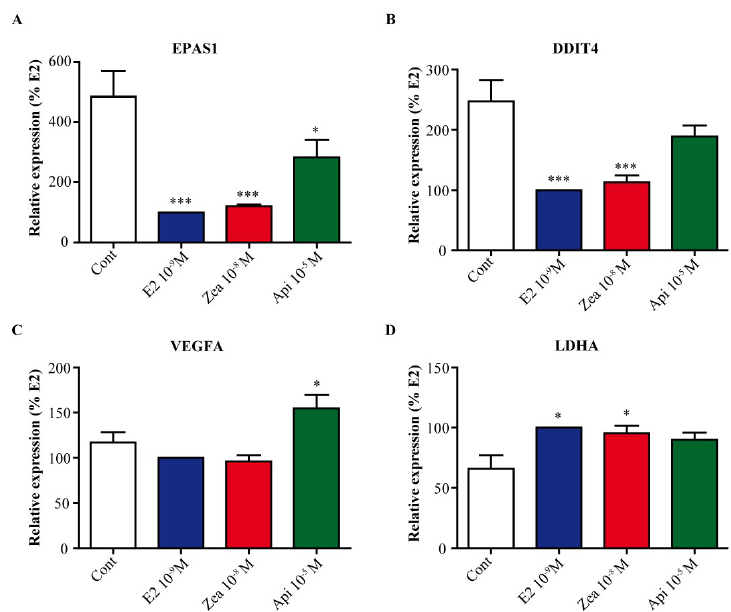
Figure 8. Validation of metabolism and growth arrest genes linked to HIF1α and EPAS1/HIF2α.MCF-7 cells were treated with solvent (white) as a negative control, 10 −9 M E2 (blue) as a positive control, 10 −8 M zearalenone (red) or 10 −5 M apigenin (green) for 24 h. The expression of EPAS1/HIF2α ( A ), DNA damage inducible transcript 4 (DDIT4) ( B ), vascular endothelial growth factor A (VEGFA) ( C ) and lactate dehydrogenase A (LDHA) ( D ) was assessed by real-time PCR. The expression level of each gene was normalized to the expression levels of the housekeeping genes GAPDH and TBP. The results are expressed as the percentage of the relative expression of transcripts obtained in E2-treated cells and are the means ± SEM of six independent experiments. * indicates a p -value < 0.05 and *** indicates a p -value < 0.001 by one-way ANOVA followed by Dunnett’s post hoc test for comparison of the control treatment with the other treatments.